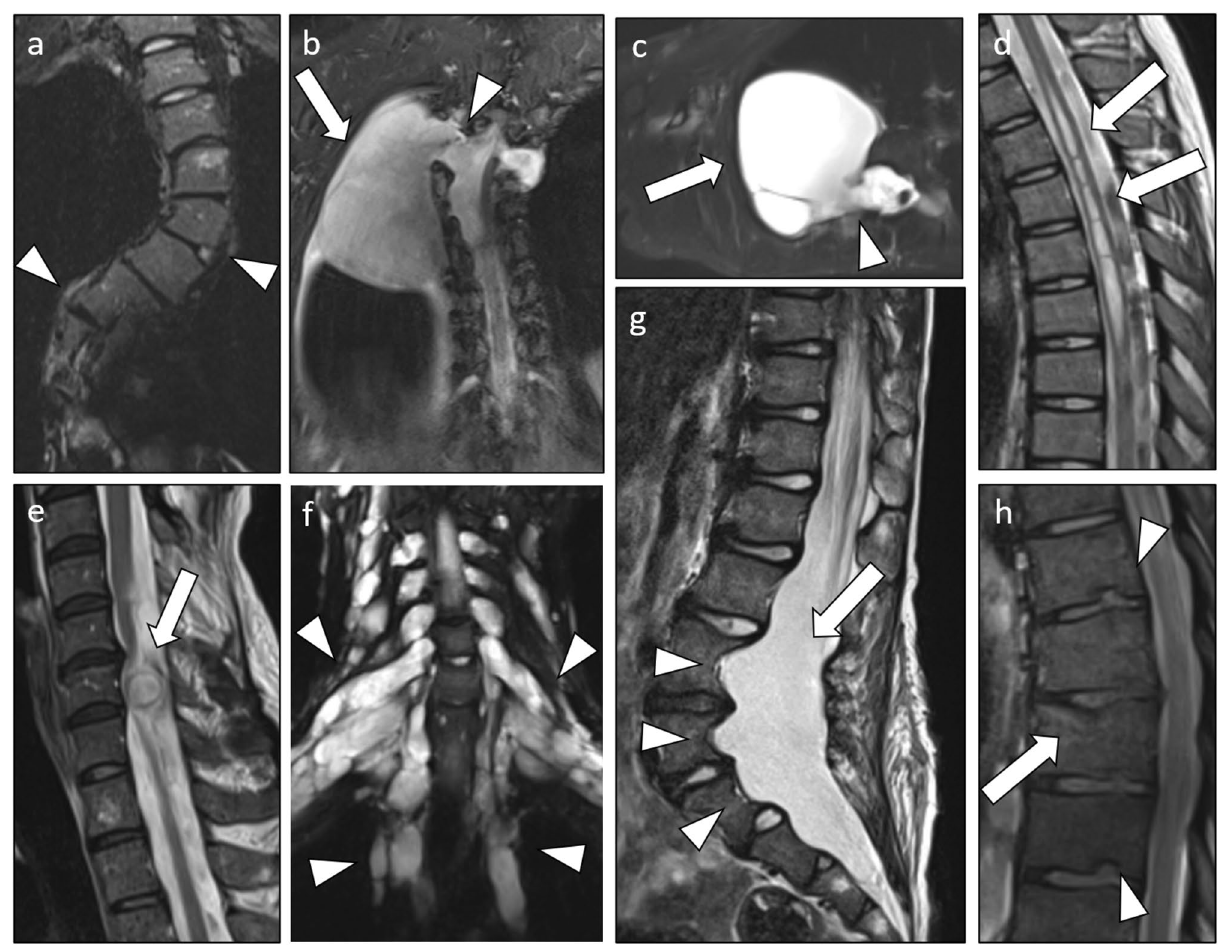
Figure 1. T2-weighted MRIs of investigated spinal abnormalities and tumors in patients with Neurofibromatosis type 1. Displayed are: A coronal image of a biconvex scoliosis of the thoracal spine ( a ). Coronal ( b ) and axial ( c ) images of a large meningocele (arrow) protruding through the enlarged neuroforamen of Th3 (arrowhead) into the thorax. A sagittal image of a septate thoracal syringomyelia (arrows) ( d ), a sagittal image of an intraspinal tumor at level C6 with compression of the spinal cord ( e ) and a coronal image of a patient with large paraspinal plexiform neurofibromas (arrowheads) growing along the whole spine ( f ). A sagittal image of a large dural ectasia (arrow) with scalloping of the lumbar vertebrae (arrowheads) ( g ) and a sagittal image of a vertebral fracture (arrow) and herniations of intervertebral discs into adjacent vertebrae (arrowheads) ( h